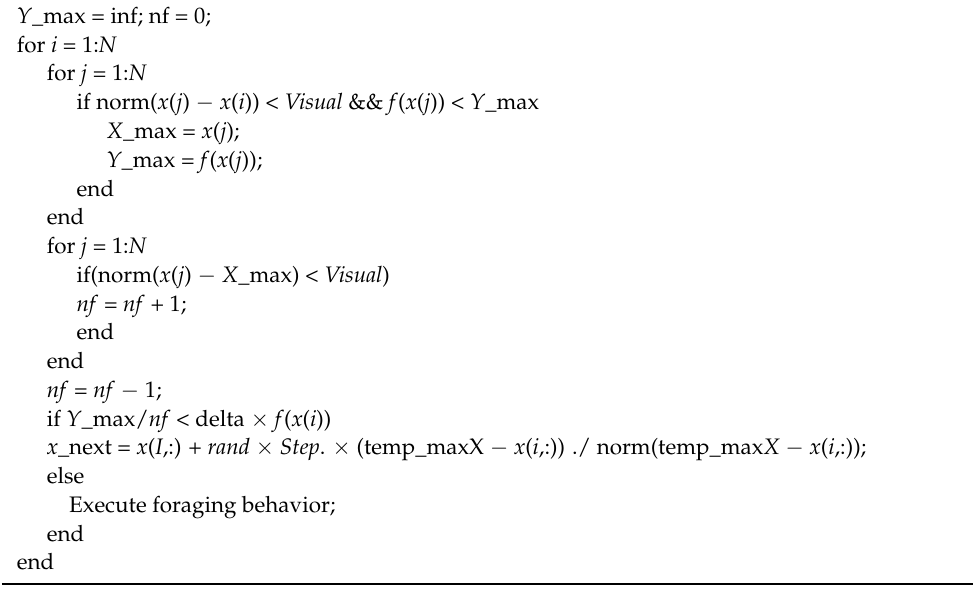
Algorithm 3 Rear-end behavior